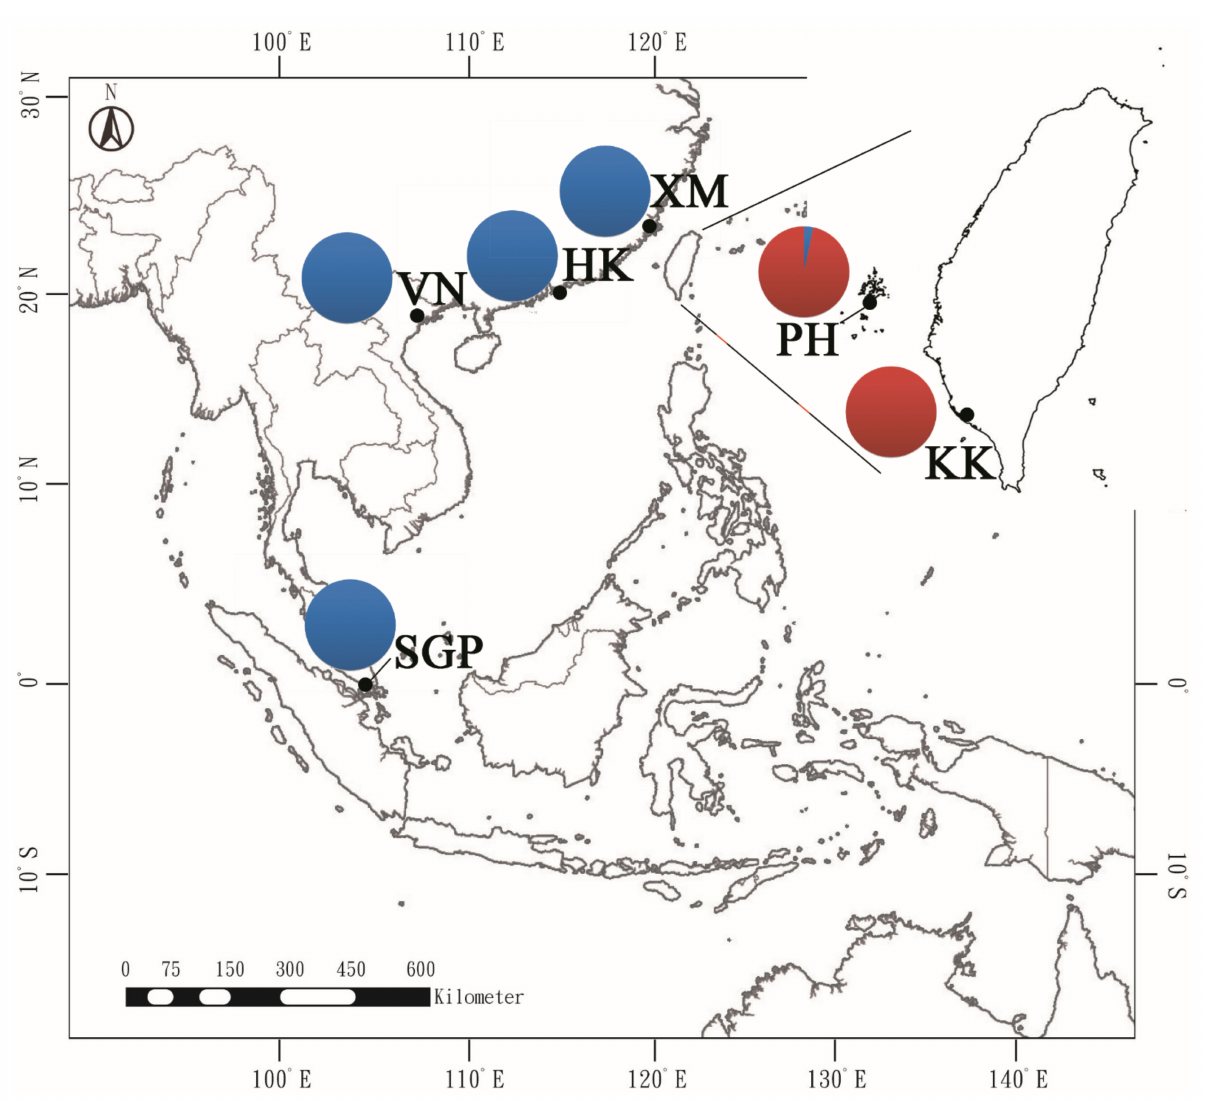
Figure 1. Sampling areas and haplotype frequencies of P. pelagicus in Southeast Asia. Table 1 presents the numbers of lineages A and B at each sampling